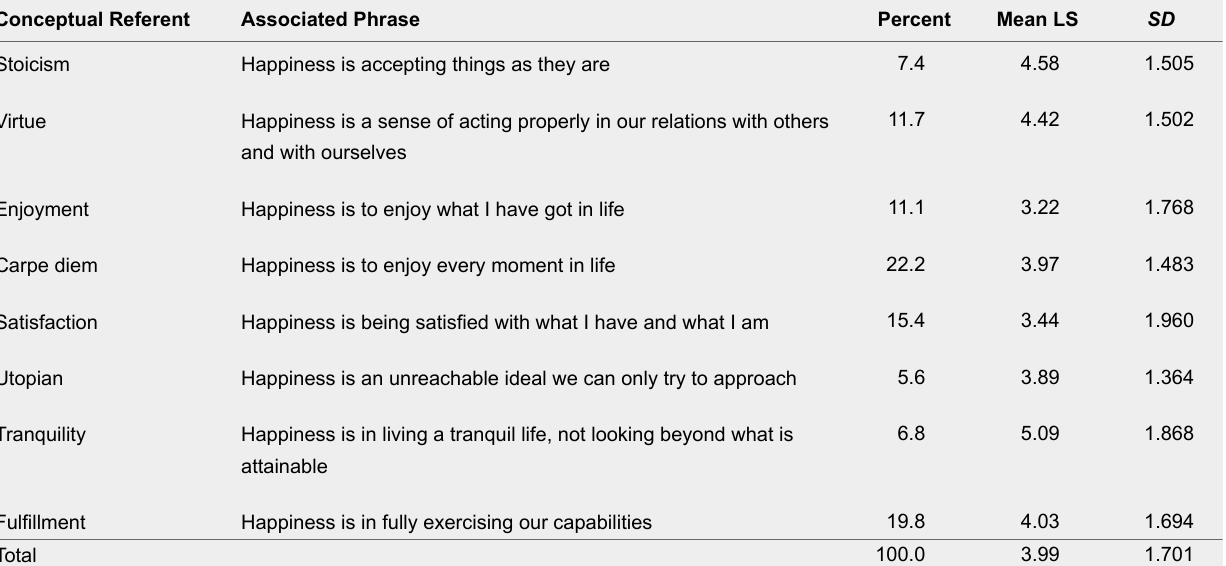
Sample Distribution and Mean Life Satisfaction Scores of Conceptual Referents